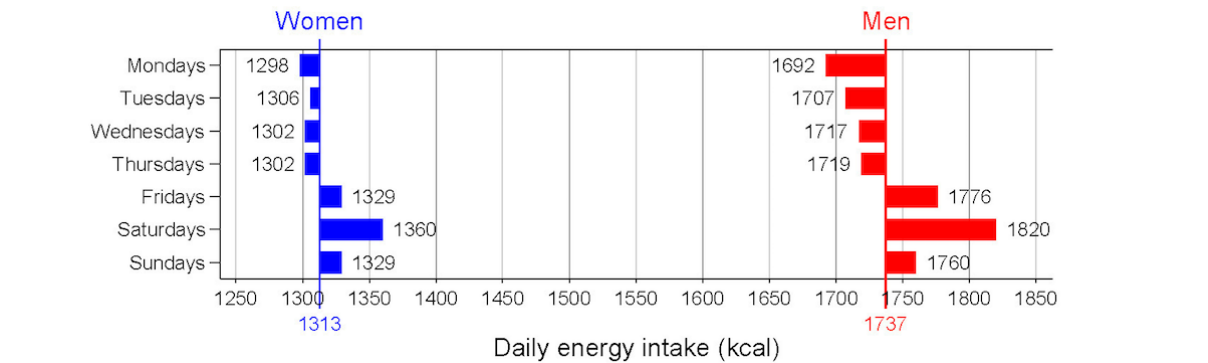
Figure 2. Caloric intake by day of the week relative to mean caloric intake for women (n=4702) and men (n=2305) who used the Lose It! mobile phone app.